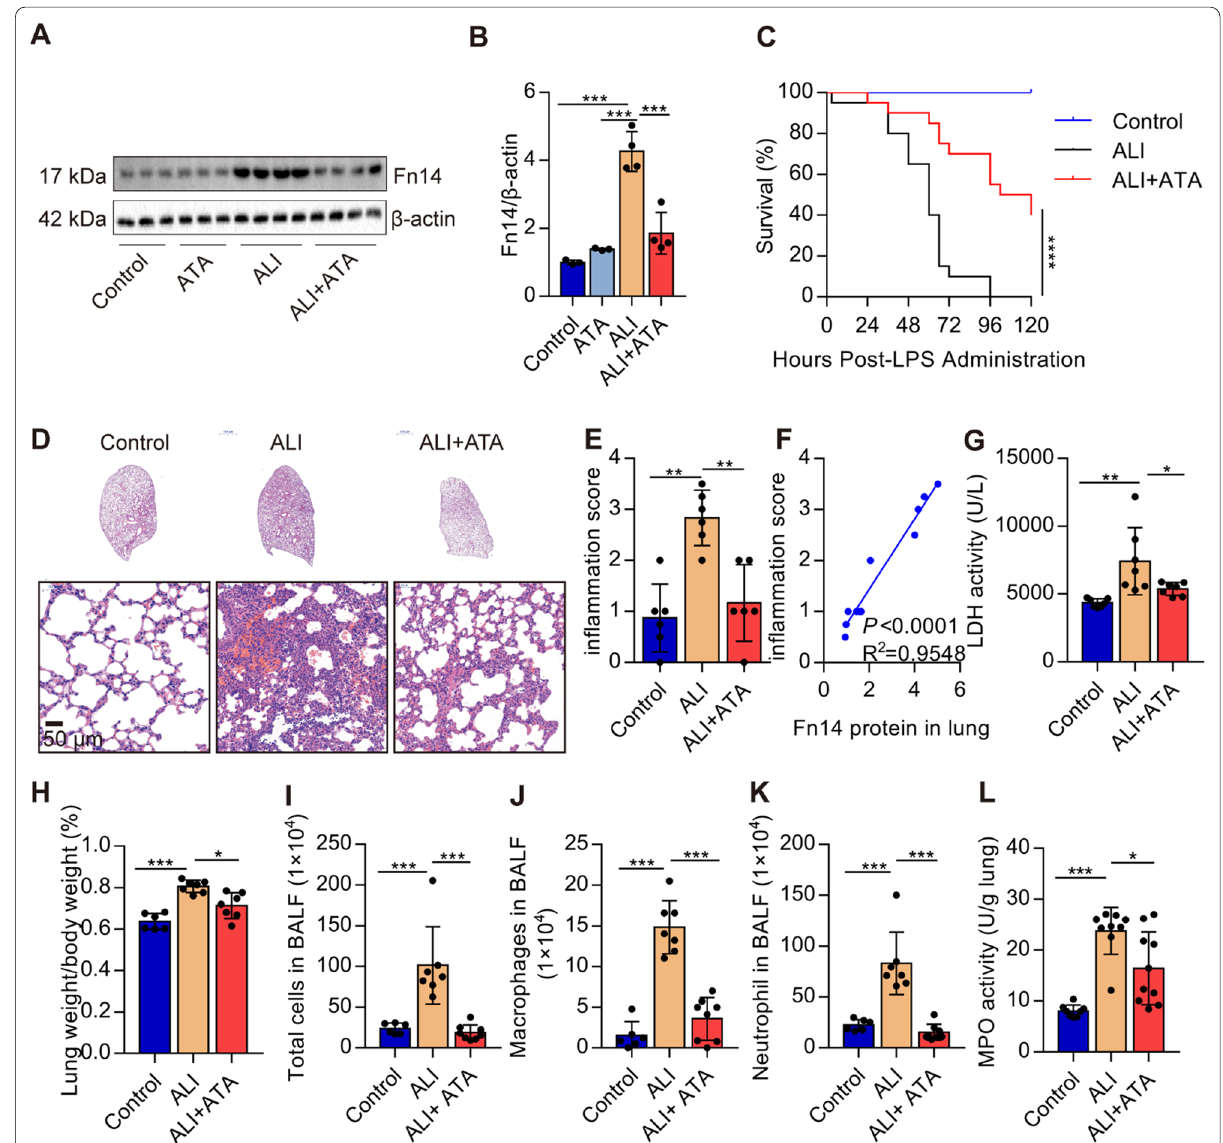
Fig. 2 Blockade of Fn14 by ATA alleviates LPS‑induced ALI in mice. ATA (20 mg/kg) was administered to mice 1 h before induction of ALI by LPS (5 mg/kg). A , B The protein expression of Fn14 in the lungs was determined by Western blot ( n 4). C The mortality was monitored every 6 h over = 120 h ( n 20 per group). C57BL/6J mice were treated with saline or ATA (20 mg/kg). One hour later, mice were given saline or LPS (5 mg/kg, i.t. ). = D Twelve hours later, the lung histopathological change was determined by H&E staining (Bar 50 μm). E The change in lung inflammation score = was determined ( n 6). F The linear associations between the expression of Fn14 protein and inflammation score were analyzed with Pearson = correlations analysis. G The activity of LDH in BALF was determined ( n 6–7). H The lung weight/body weight ratio was determined ( n 6–7). = = I–K The Quantification of total cells, macrophages, and neutrophils in BALF was determined (n 6–7). L The activity of MPO in lung tissue was = determined ( n 6–10). Data are expressed as the mean SD. Differences among multiple groups were performed using ANOVA. Tukey’s test was = ± used as a post hoc test to make pair‑wise comparisons. Survival data were analyzed using the log‑rank test. * P < 0.05, ** P < 0.01, and *** P <